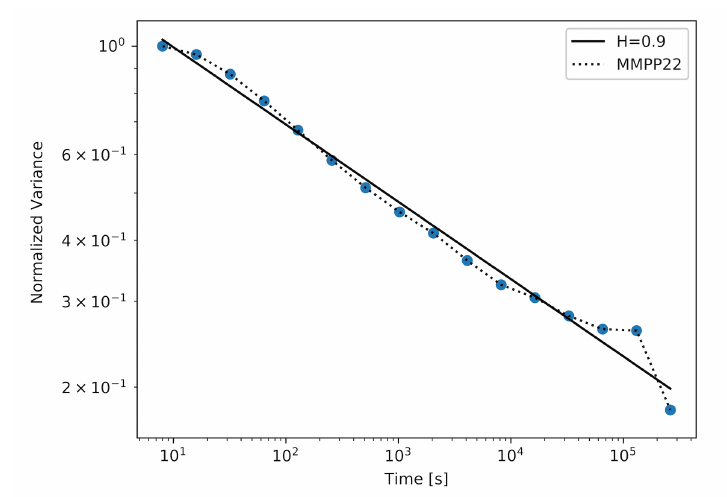
Figure 5. The aggregate variance of the sample in several time scales with the MMPP model, d = 22.